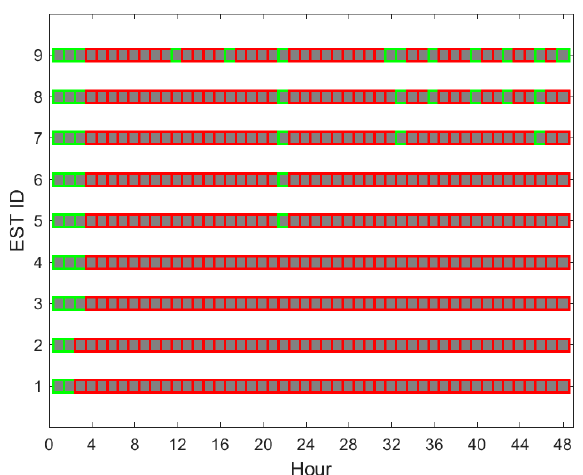
Figure 5. The availability of 9 ESTs serving the logistics system where the red color represents the unavailability of the corresponding EST at the plant (on the road or at an EVCS) and the green color represents their availability.